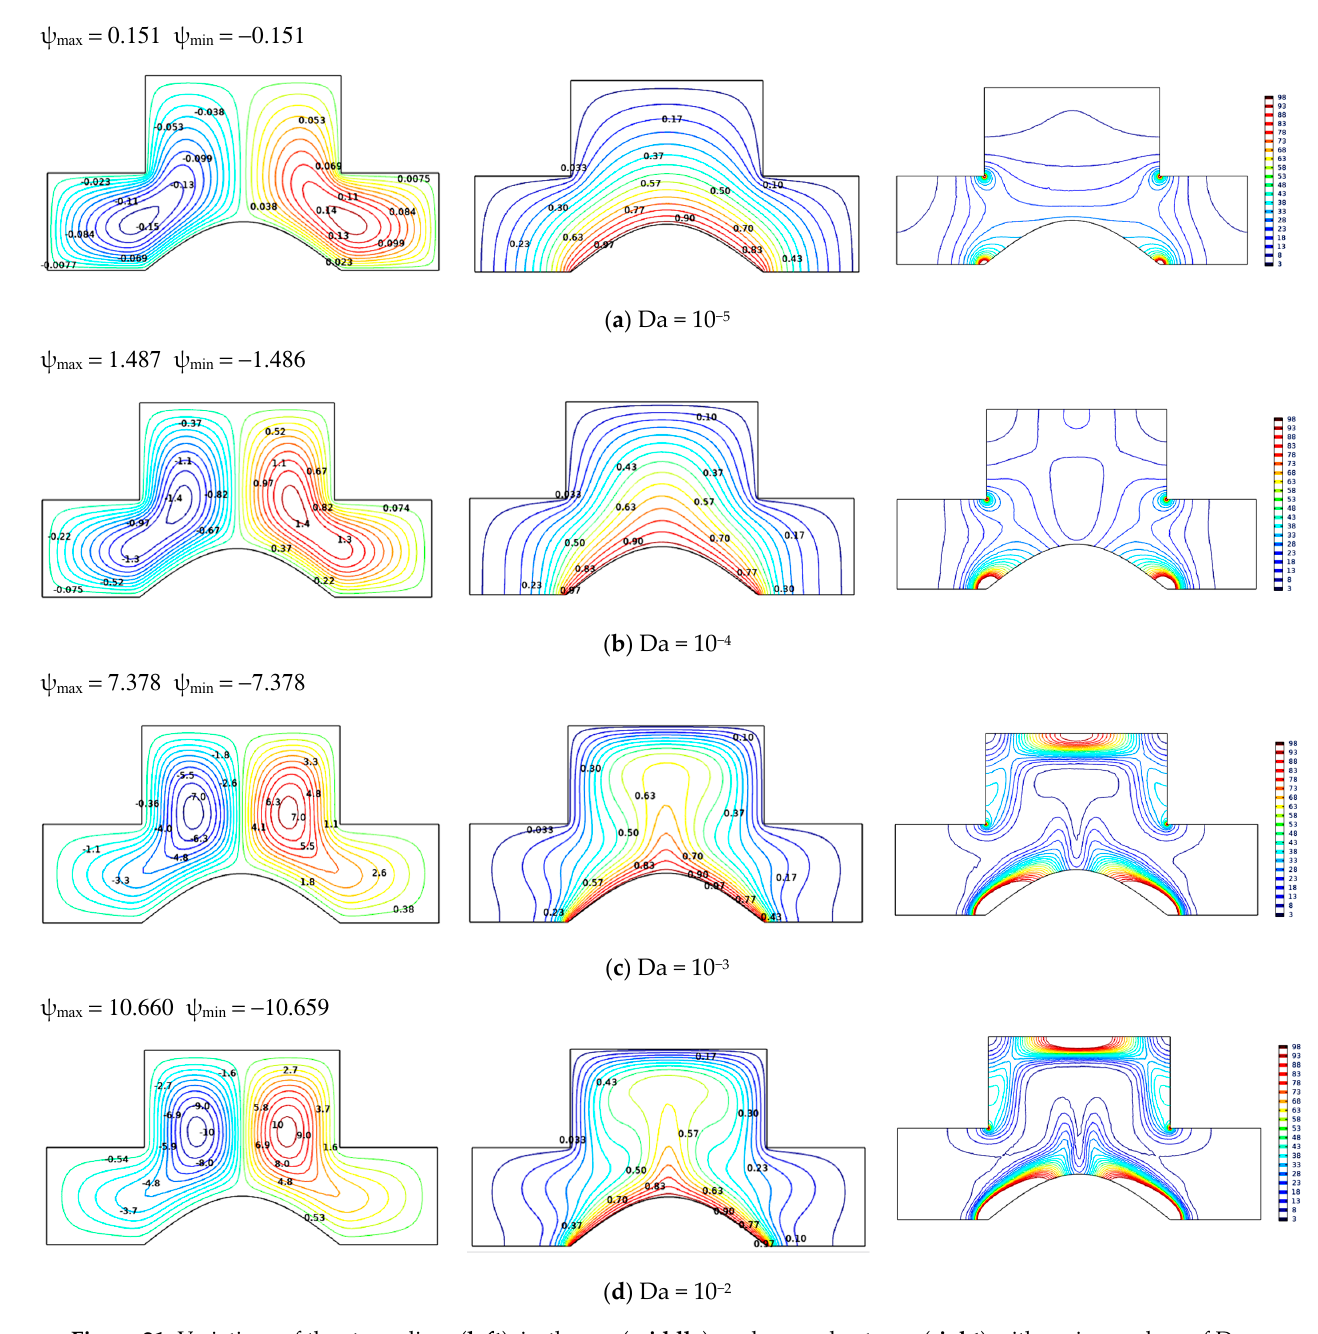
Figure 21. Variations of the streamlines ( left ), isotherms ( middle ), and general entropy ( right ) with various values of Darcy number (Da). 𝜙 = 0.02, Ra=10 6 , Ha = 0, and 𝜀 = 0.4 .